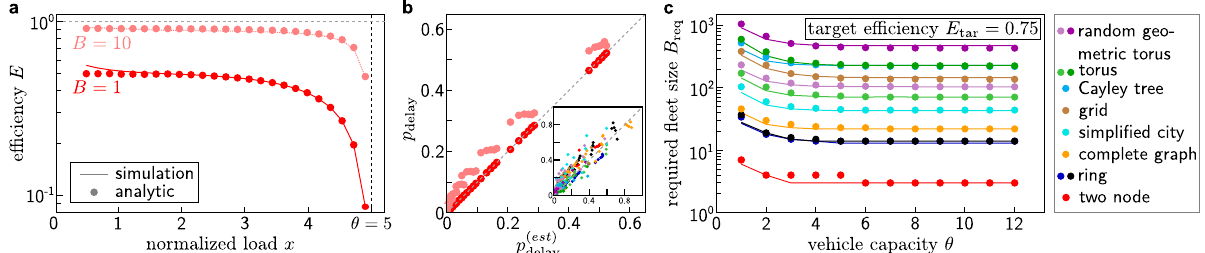
Figure 4. Fleet size prediction for capacity-constrained ride-pooling services. ( a ) Queueing theory predictions (dots) of the ride-pooling efficiency in a minimal two-node setting. The predictions become exact for a single vehicle B = 1 (dark red) at high load x where the vehicle is never idle. Small deviations for larger fleet sizes ( B = 10 , light red) reflect the non-equidistant inter-arrival time distribution of vehicles. ( b ) The same queueing theoretical description predicts the scaling parameter p delay for various loads x and capacity constraints θ .